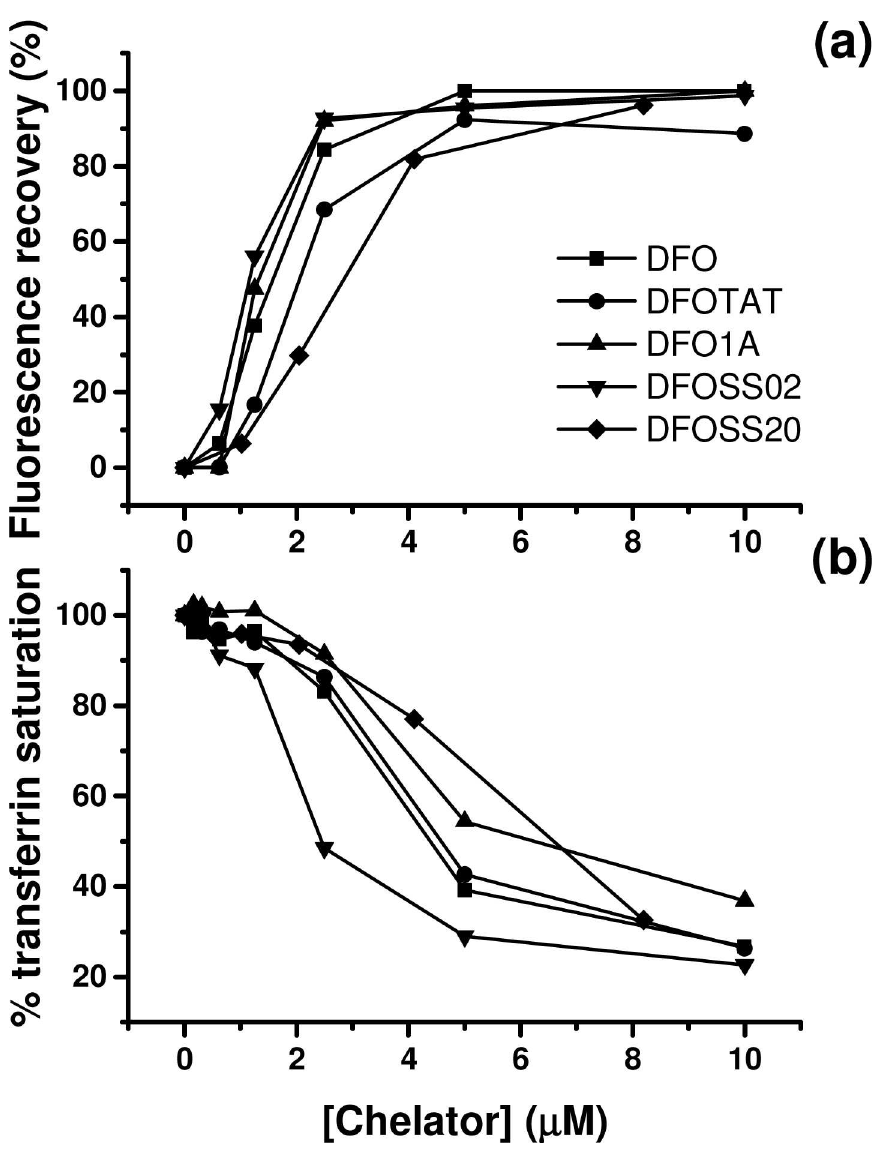
Fig 2. Iron-binding ability of mtDFO. (a) Fluorescence recovery promoted by mtDFO competingwith 2 μ M CAFe. (b) Percentageof transferrin saturation by iron when 2 μ M Fl-aTf is mixed with increasingamountsof mtDFO. Results are the averageof quadruplicates and representative of at least two isolatedexperiments. The samples do not show statistic